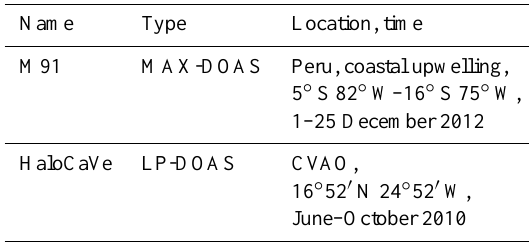
Table 1. Information about the campaigns from which measurement data were